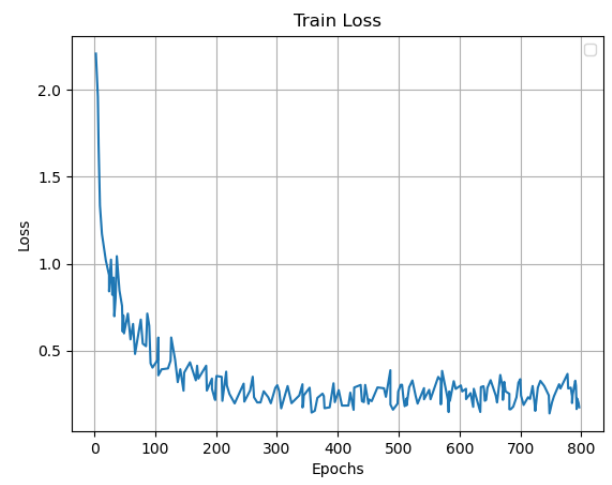
Figure 10. Classifier loss convergence graph.